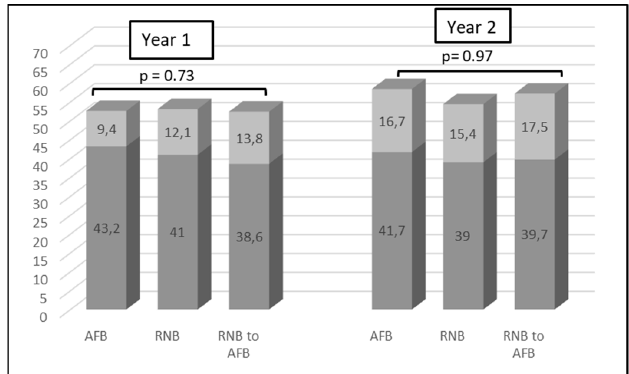
Figure 1. The percentages of eyes that achieved more than 10 letters gain and more than 10 letters loss in vision at month 12 and 24 among study groups.